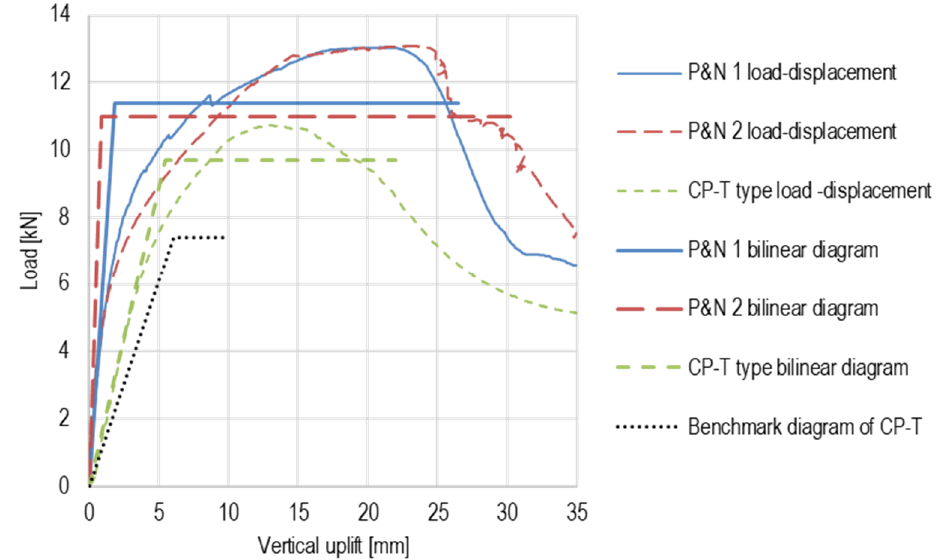
Figure 13. Load–displacement curves and bilinear diagrams of the pullout tests.